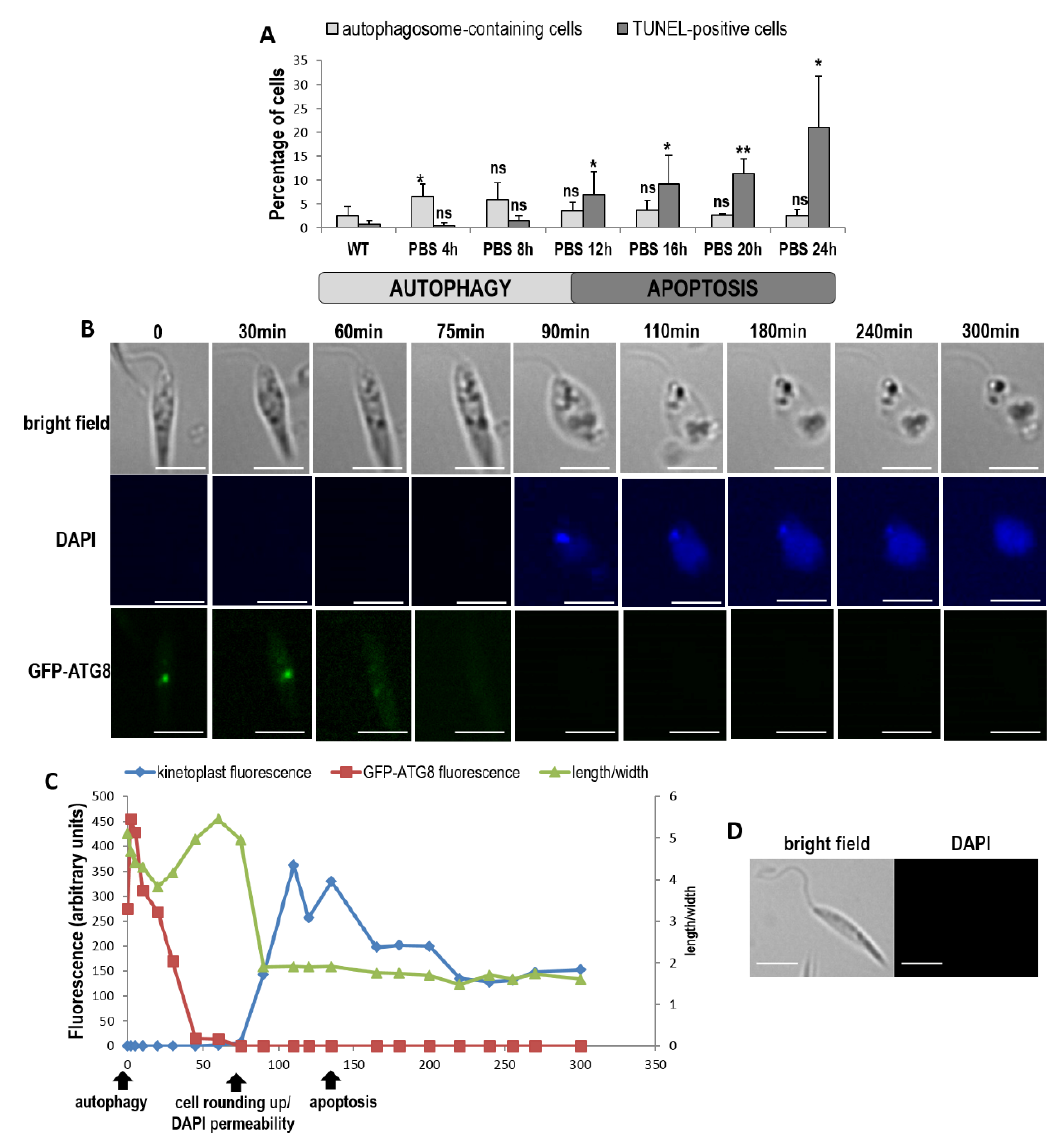
FIGURE 6: When cultivated in PBS, cells first enter autophagy and then die when nutrients are lacking. (A) Percentage of autophagosome- containing cells (punctuated ATG8) and TUNEL-positive cells during culture of cells in PBS for 24 h (≥ 1128 cells from a minimum of three independent experiments for the ATG8 assay and from a minimum of five independent experiments for the TUNEL assay). Unpaired t-test: ns not significant, * p < 0.05, ** p < 0.01. (B) Real time microscopy of a representative GFP-ATG8 cell cultivated in PBS, showing ATG8 punctuated staining disappearance, nucleus and kinetoplast DAPI staining appearance concomitant with cell rounding up, then kinetoplast fluorescence decrease (bar = 5µm). (C) Sequence of events observed in the cell represented in (B) , showing the death (characterized by DAPI permeability, cell rounding up and low kinetoplast fluorescence) of an autophagic cell (with GFP-ATG8 puncta). (D) Microscopical images of a cell in control conditions (cell cultivated in medium and not in PBS) representative of all the cells observed in the same conditions as in (B) , for 300 min (bar = 5